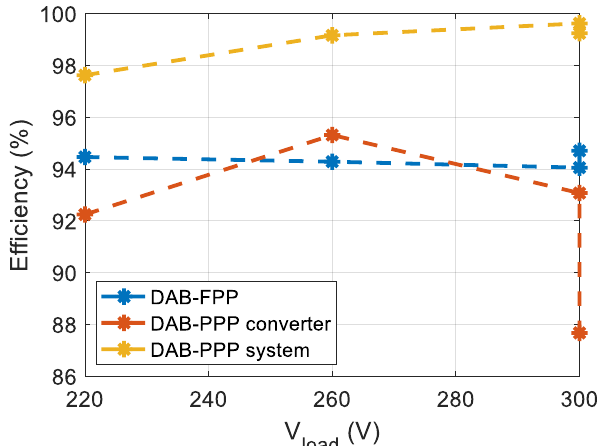
Figure 16. Efficiency obtained by the prototypes.